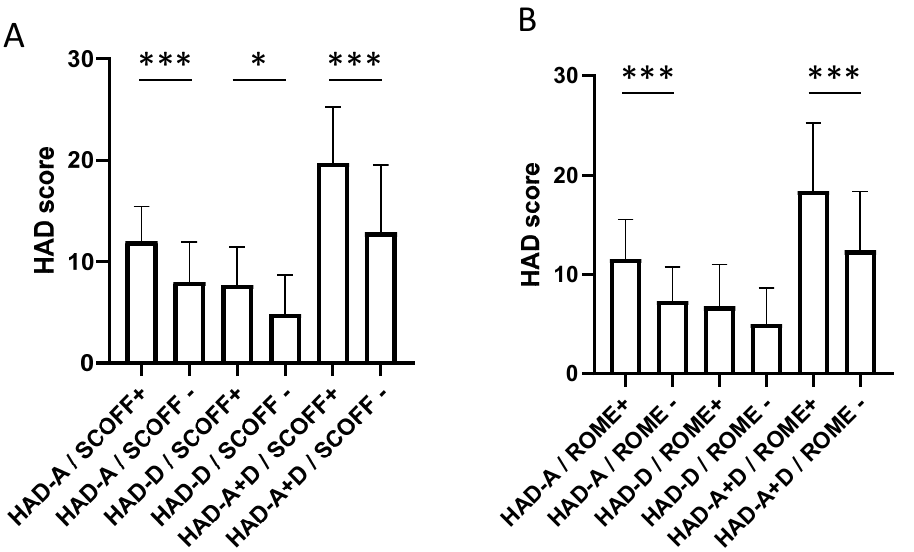
Figure 3. Response to the HAD questionnaire according to SCOFF-F status ( A ) and ROME IV status ( B ). *, p < 0.05; ***, p < 0.0001; HAD-A: HAD-Anxiety; HAD-D: HAD-Depression; HAD A + D: HAD-Anxiety and Depression; ROME+: ROME-IV positive; ROME − : ROME-IV negative; SCOFF+: SCOFF-F positive; SCOFF − : SCOFF-F negative.